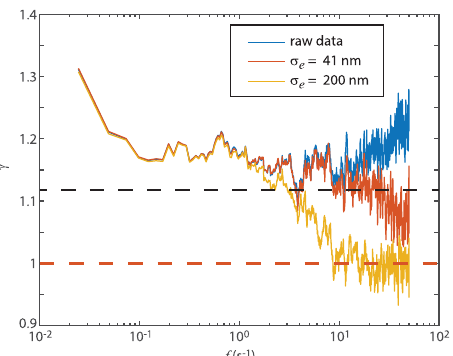
Fig. 4 Coef fi cient of variation obtained from diffusive data of beads in water. The baseline is marked in blue. Static localisation errors are arti fi cially added to the data to obtain the other two curves. The red and ffiffiffi p = 2, respectively, which are the black dashed lines indicate γ = 1 and 5 values to which γ converges in the case of subdiffusion and normal diffusion when no error is present.